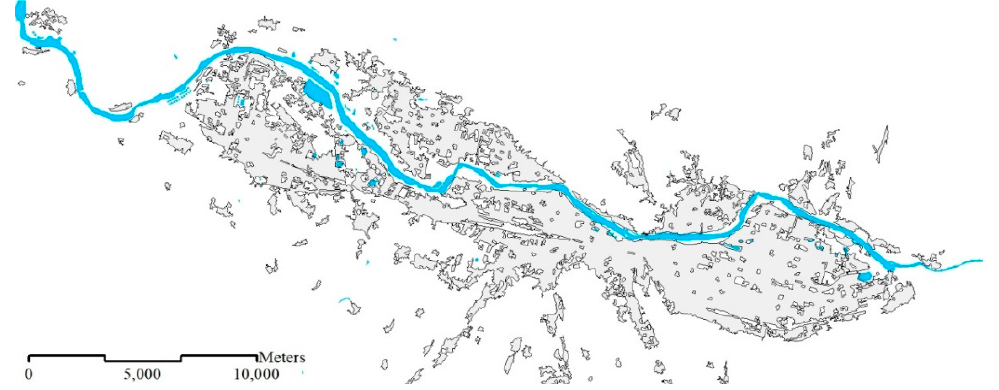
Figure 13. Urban areas obtained from the proposed approach.